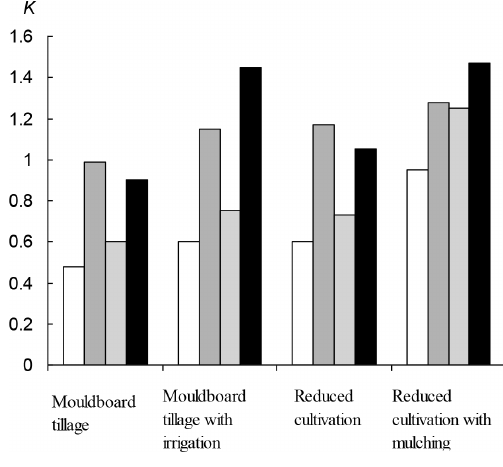
ing into account the change in soil energy for wheat production at the following agrometeorological stations: Ershov (empty boxes), Bezenchuk (dark grey boxes), Kamennaya Step’ (light grey boxes), and Petrinka (black